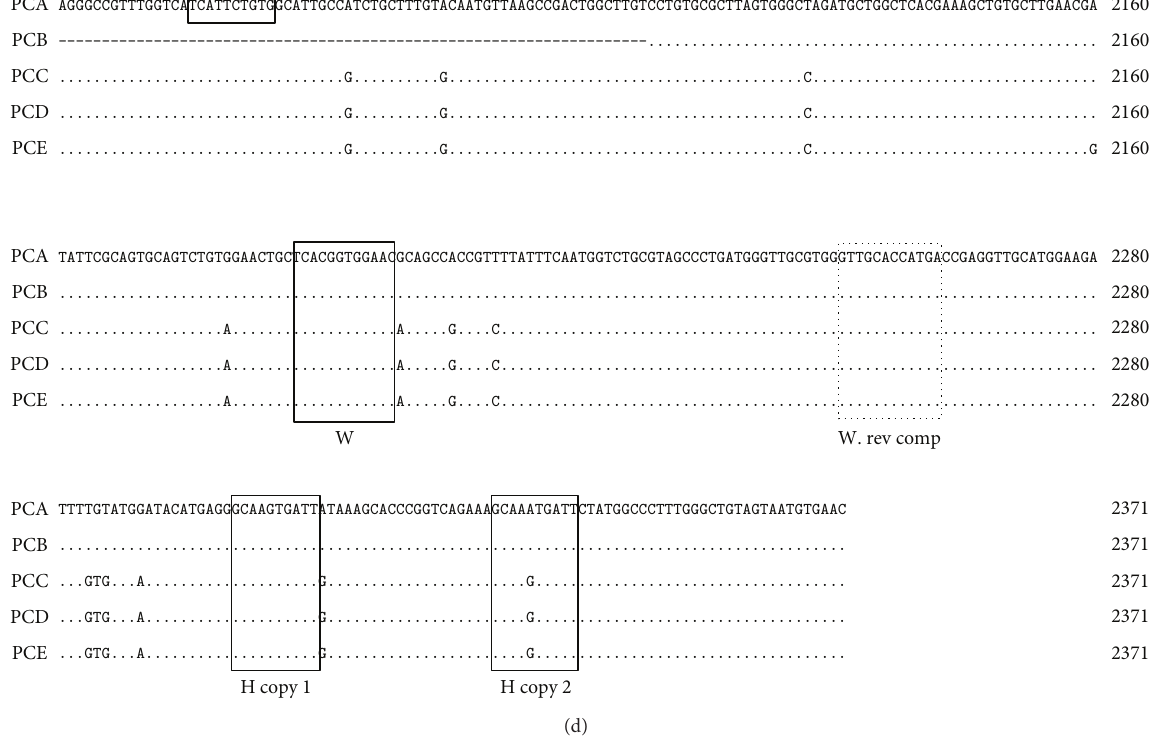
Figure 3: The alignment of intergenic spacer (IGS) rDNA sequences of the five individual Paramphistomum cervi . Dots denote sequence identity to the first sequence. Dashes represent nucleotide